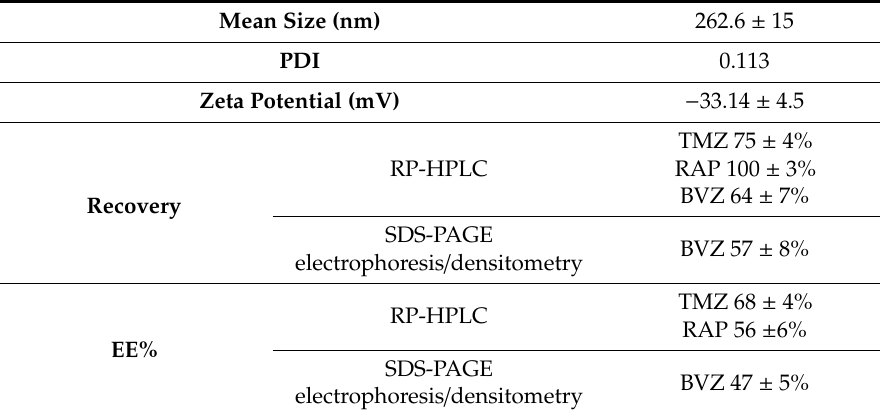
Table 1. IL MIX physico-chemical characterization. PDI: polydispersion Index; RP-HPLC: reverse phase high pressure liquid chromatography; SDS-PAGE: sodium dodecyl sulphate polyacrylamide gel electrophoresis; EE%: % entrapment e ffi ciency.